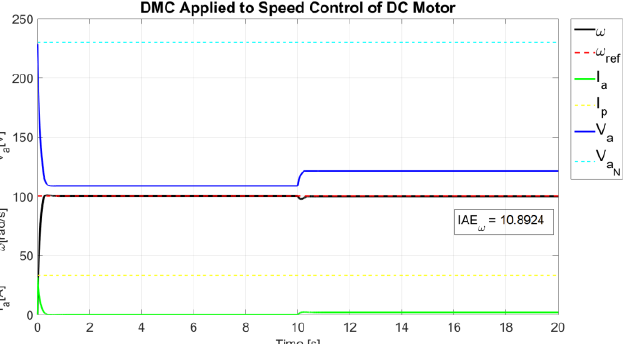
Figure 8. DC motor controlled by DMC tuned by hybrid method (ωref = 100 rad/s).